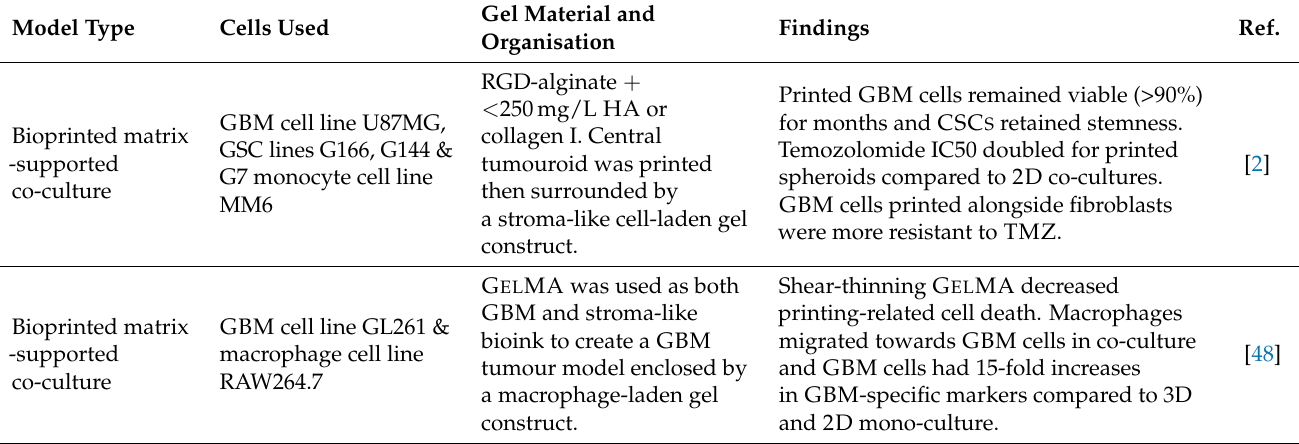
Figure 2. A schematic representation of co-printed disease models with two distinct gel formulations arranged spatially with filament- and droplet-style bioprinting. Table 7. Key findings reported with the use of bioprinted glioblastoma models. No bioprinted paediatric GBM models were found at the time of